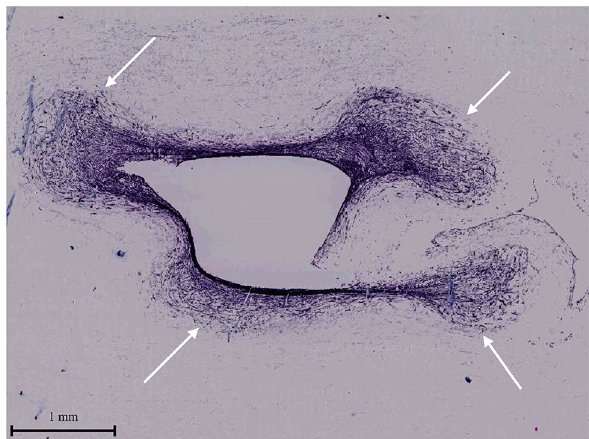
Figure 5. Infiltration of fibroblasts into a glass fiber. White arrows: invasive growth areas.